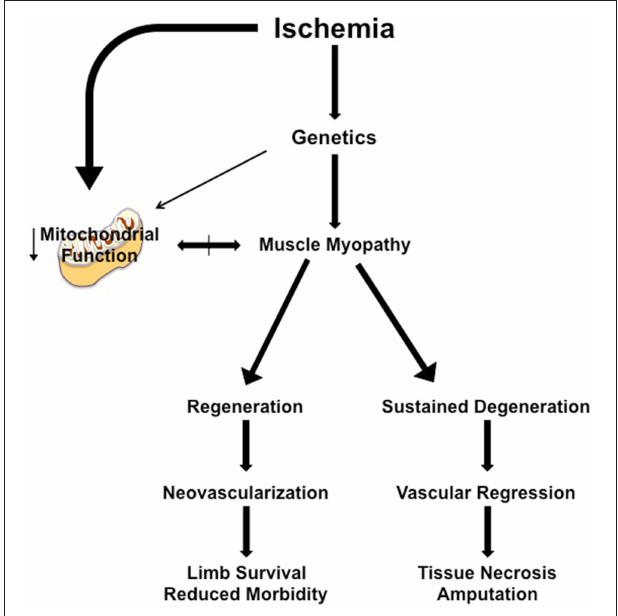
FIGURE 1 | Simplified model of the proposed role of muscle myopathy in the progression of limb pathology in critical limb ischemia. Individual genetics play a role in determining the severity of the ischemic manifestation of limb pathology. Clinical interventions (endovascular or revascularization in nature) occur after the patient clinically presents with identifiable symptoms/manifestation of PAD, at a time when muscle myopathy is initiated or ongoing. Ischemic muscle myopathy involves muscle degeneration/regeneration cycles that: (1) function properly and result in a limb tissue microenvironment that is supportive of neovascularization and/or the clinical intervention, reducing morbidity and increasing the likelihood of limb survival, or (2) improperly function, resulting in a microenvironment that promotes continued degenerative myopathy and vascular regression that ultimately leads to tissue necrosis, morbidity, and secondary amputation. The role of mitochondrial function in ischemic limb muscle myopathy is not currently understood, but represents an exciting area for therapeutic